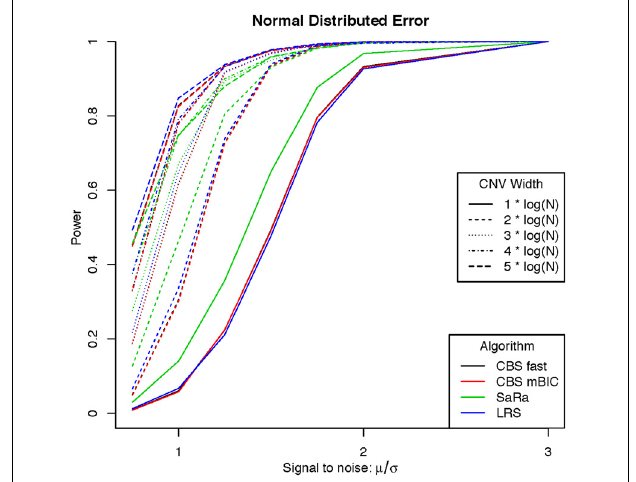
FIGURE 1 | Power for different signal to noise and CNV width under a normal distribution.